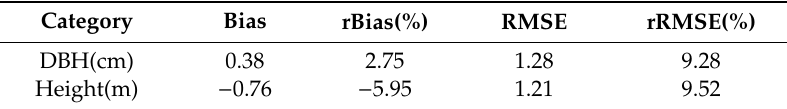
Table 2. Accuracy comparison of DBH and tree height obtained by using this model and field measurement.